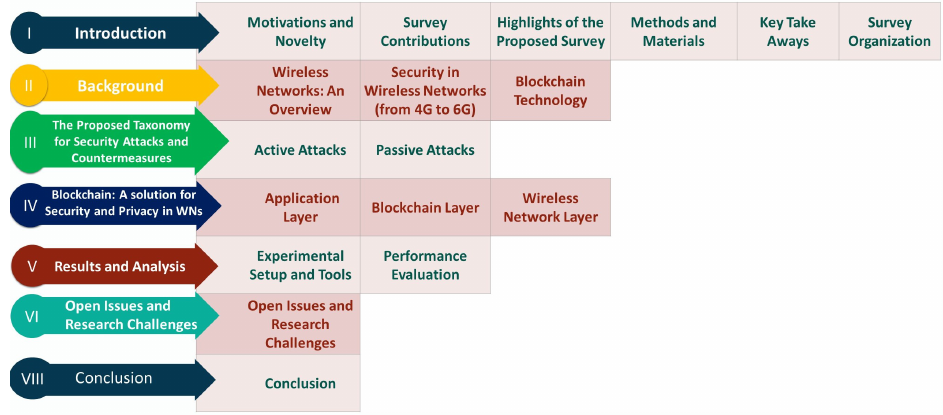
Figure 2. Organization of the